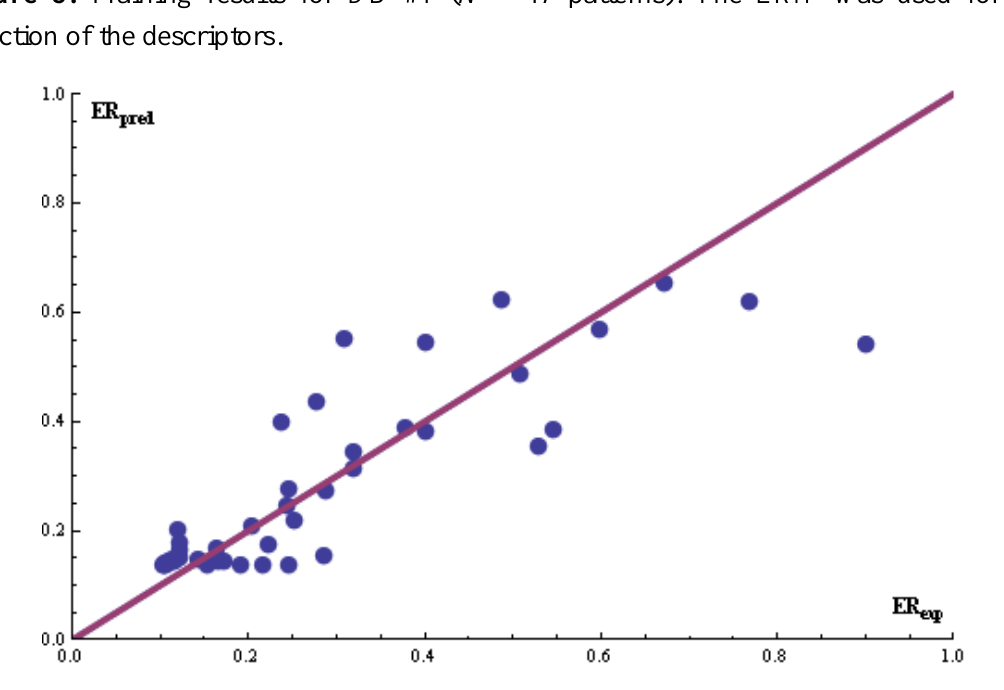
Figure 6. Testing results for DB #1 ( N = 14 patterns). The enhanced replacement method was used for the selection of the